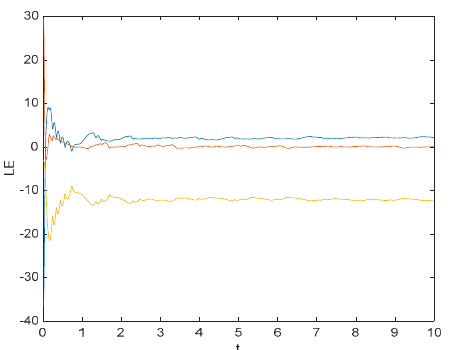
Figure 2. Time domain waveform of integer-order unified chaotic system with α = 1. ( a ) x ( t ); ( b ) y ( t ).